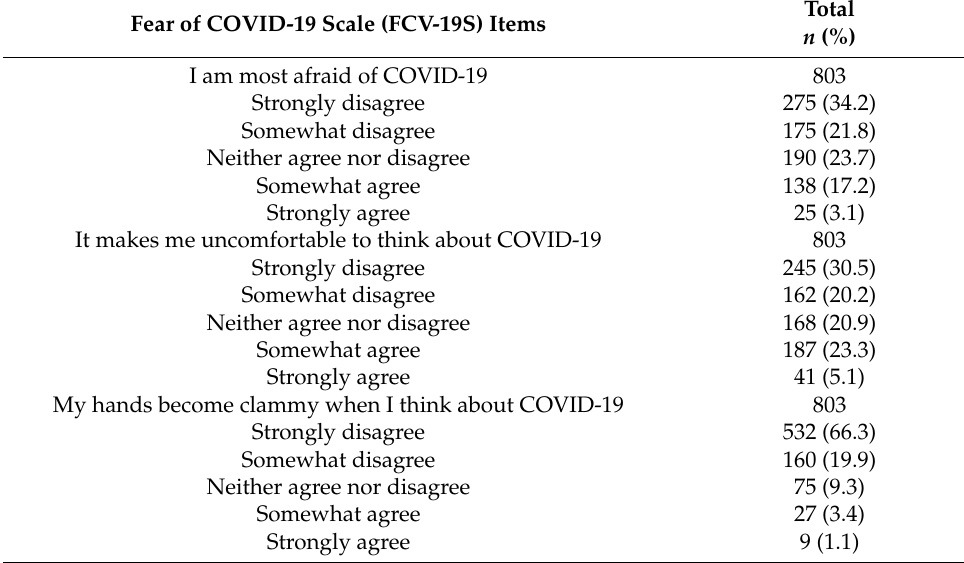
Table 4. Fear of COVID-19 among adults in Saudi